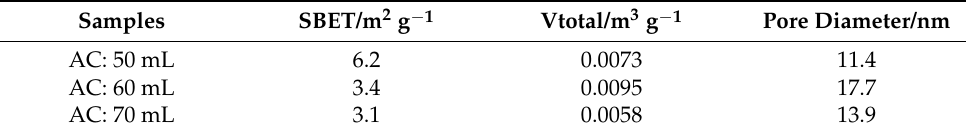
Table 3. Pore characteristics of NCM622 different ammonia content.